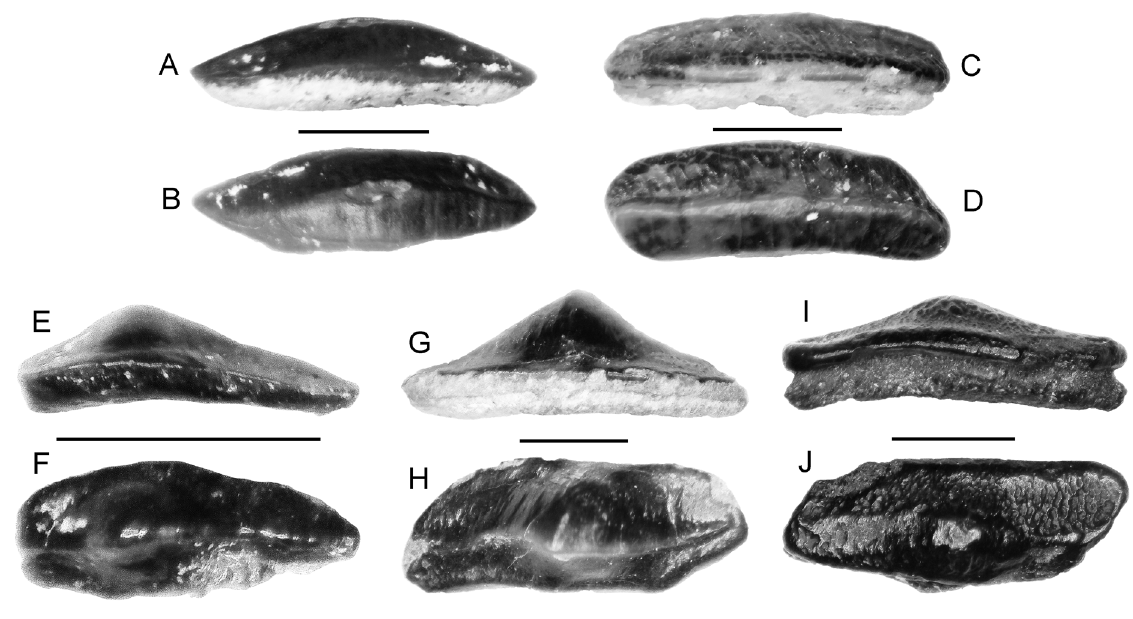
Fig. 5. Heterodontus sp. lateral teeth. A – B . MSC 35769.2, lower Tallahatta Formation. A .